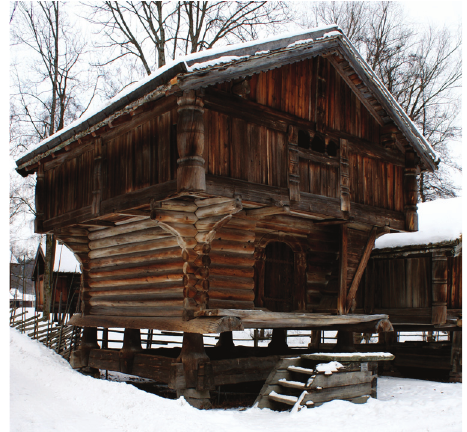
Figure 1: The storage house from Tveito, Telemark, in its new environment at the Norwegian Folk Museum in Oslo. The ground floor portal and its three-dimen- sional carved capital lions can be glimpsed from a distance. Photo: